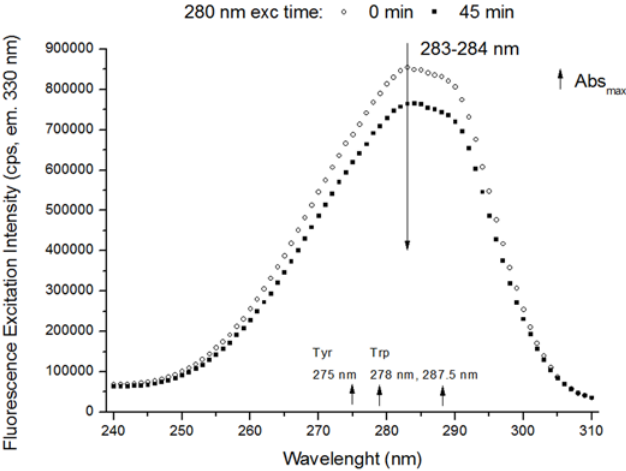
Fig 5. Fluorescence excitation spectra of human plasminogen (330 nm emission). The excitation spectra (em. 330 nm) were obtained before and after 280 nm light continuous illumination (45 min) of human plasminogen in solution. After 45 min of 280 nm illumination there is a decrease in excitation intensity at ~283 nm. Small increasing arrows indicate the wavelengths of maximum absorption (Abs max ) of Trp and Tyr in